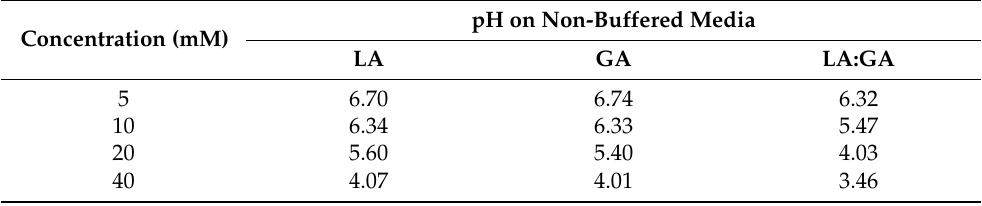
Table 1. pH measurements for each non-buffered acidic medium (LA, GA, and LA:GA) at different concentrations (5, 10, 20, and 40 mM). Concentration